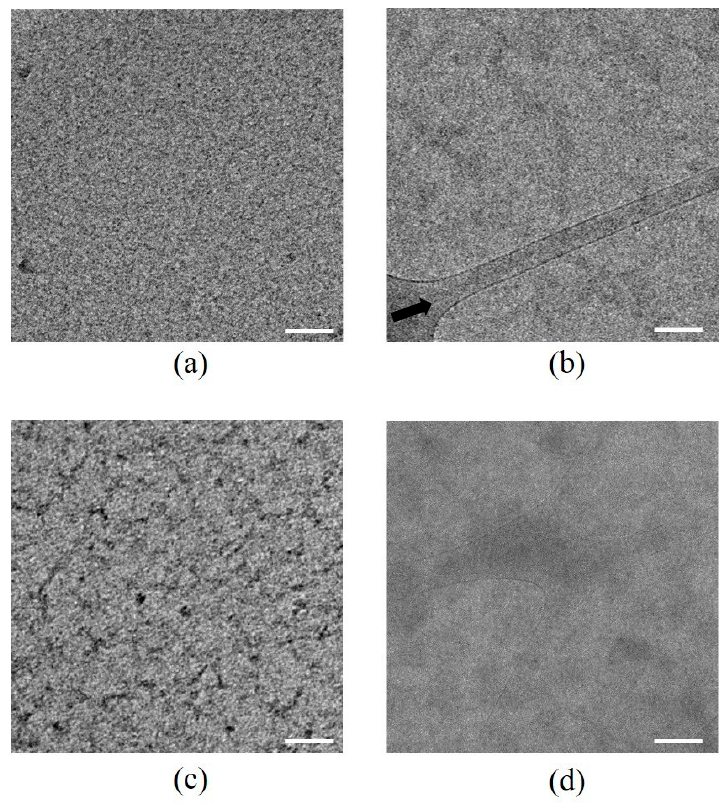
Figure 4. Cryo-TEM images of ( a ) PAA in water (depicting small aggregates), ( b ) PAA in water/ethanol (depicting diminished aggregation, the arrow marks the edge of holes in the supporting carbon film), ( c ) PAA/PAH in water (depicting larger-scale aggregates), and ( d ) PAA/PAH in ( c ) PAA / PAH in water (depicting larger-scale aggregates), and ( d ) PAA / PAH in water / ethanol (depicting water/ethanol (depicting a homogeneous solution). Scale bar = 100 nm. a homogeneous solution). Scale bar = 100